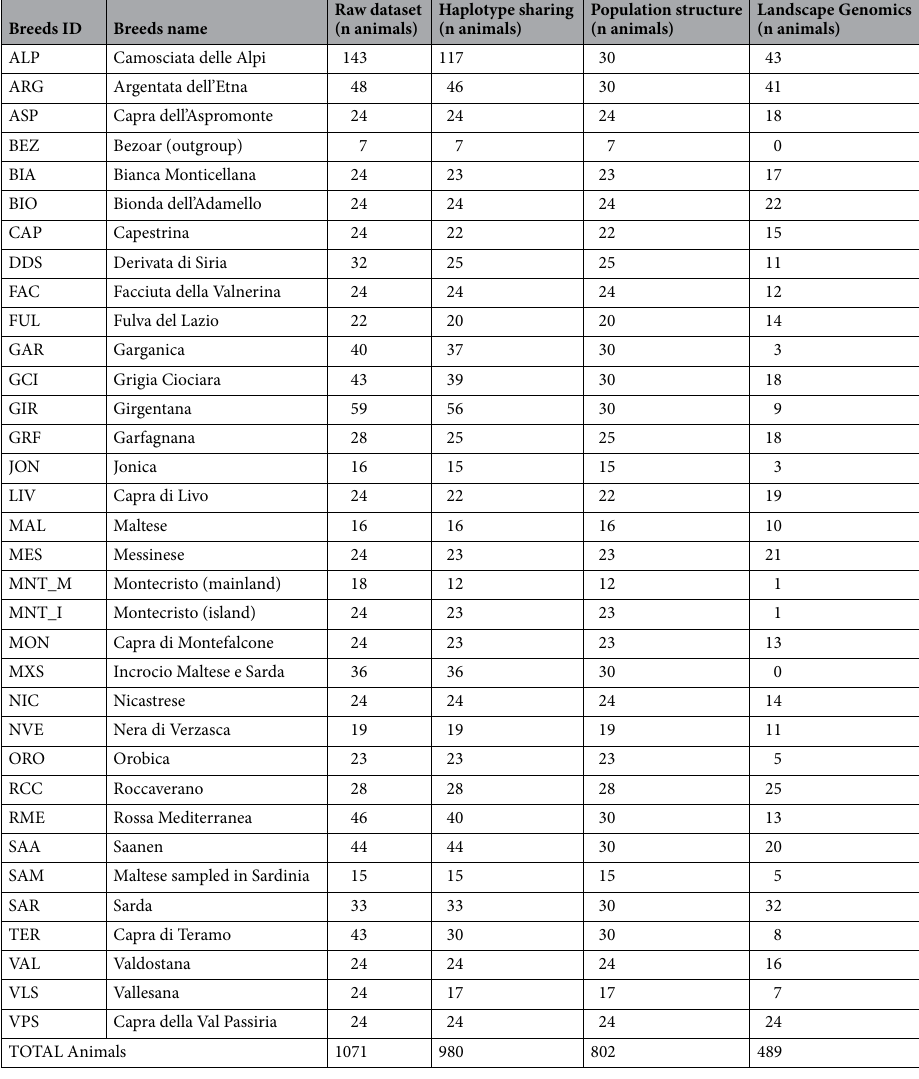
Table 1. Composition of the datasets used for the different analysis, with names, codes and number of samples processed and filtered for each population and grouped by the type of